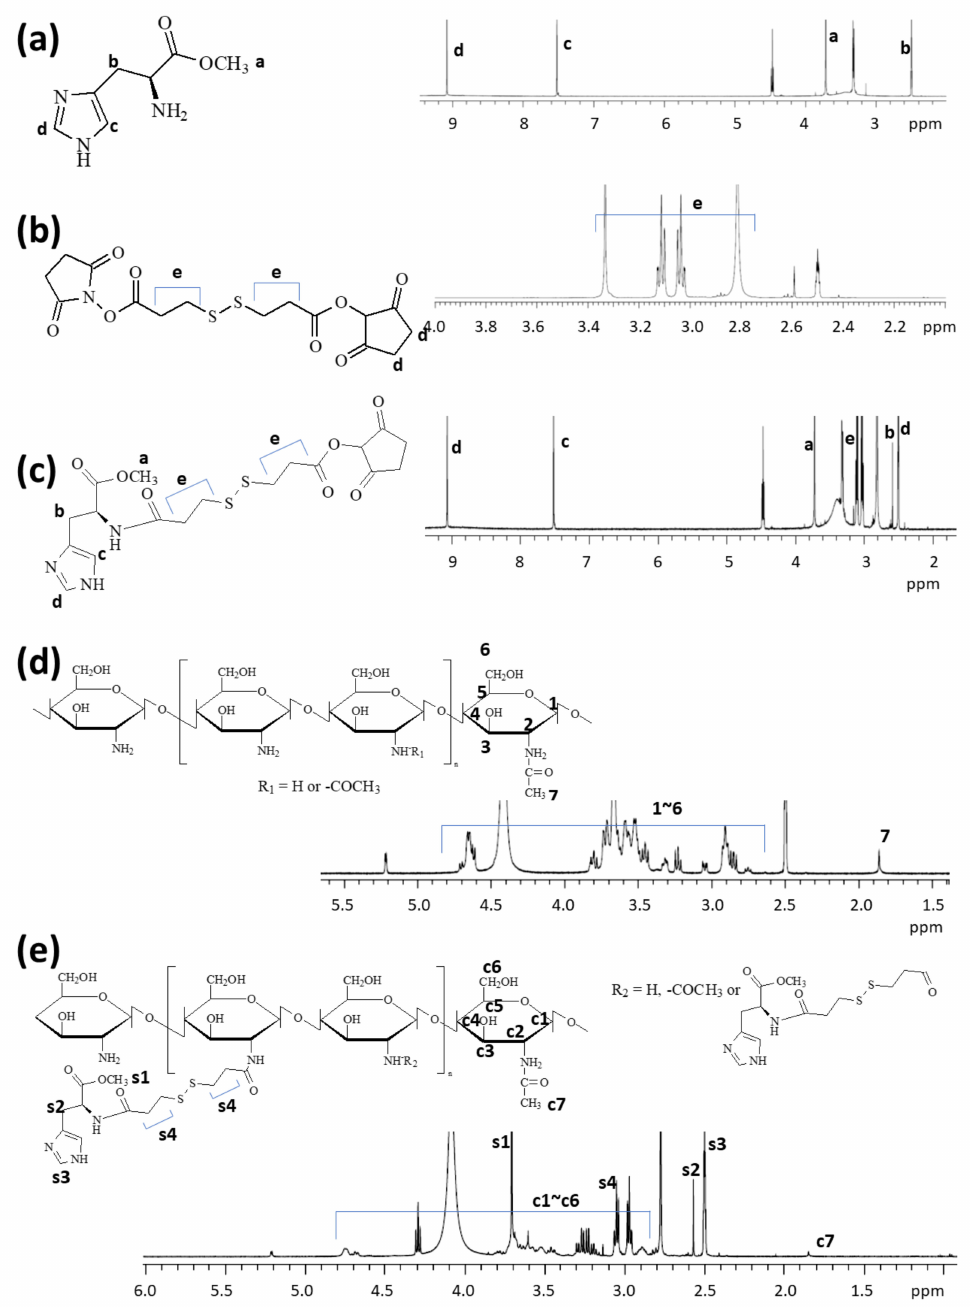
Figure 1. Chemical structure and 1 H NMR spectra of ( a ) L-histidine methyl ester (HIS), ( b ) dithiodipropionic acid N-hydroxysucinnimide ester (DTP-NHS), ( c ) HIS-DTP-NHS, ( d ) COS, and ( e ) ChitoHISss